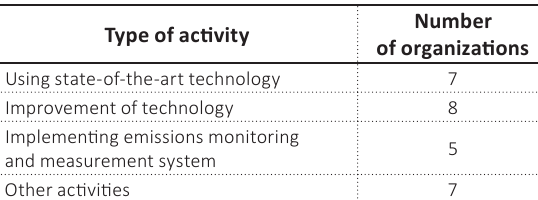
Table 1. Types of activities most